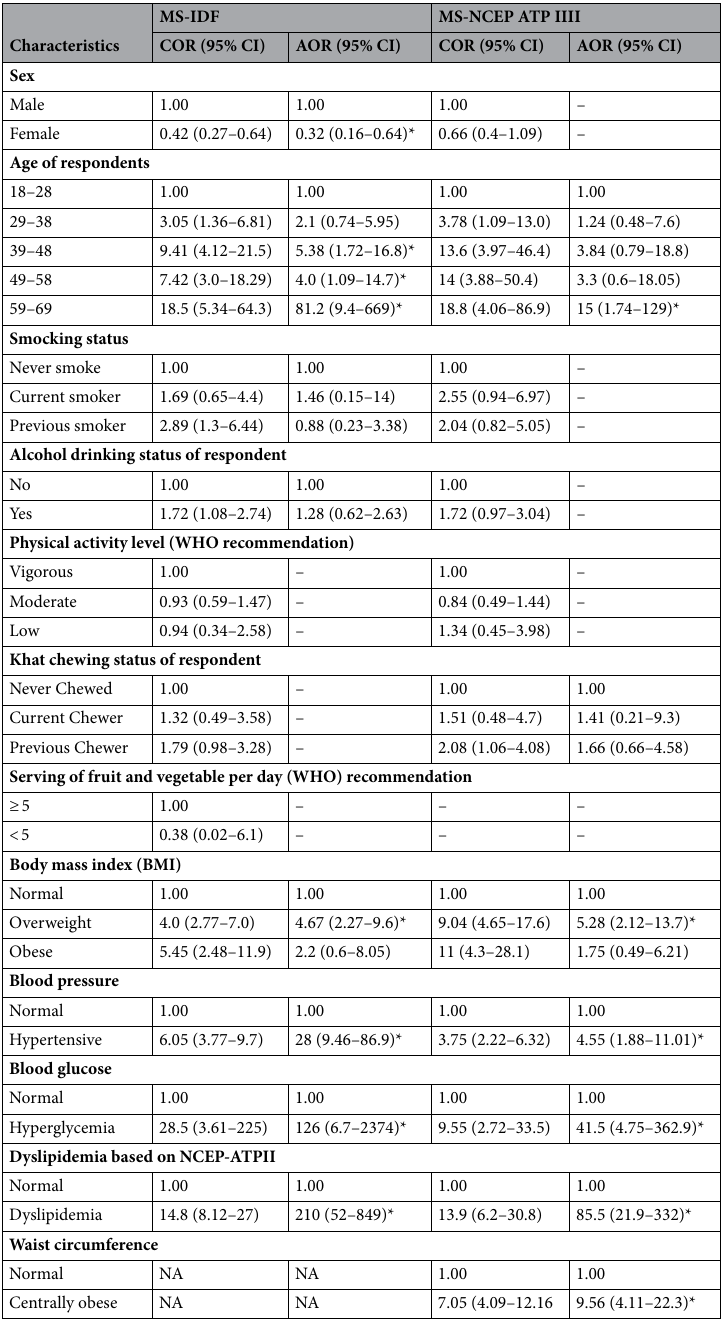
Table 6. Bivariate and multivariate analyses of risk factor components for metabolic syndrome of study subjects. EPHI, Addis Ababa, Ethiopia, 2018 (n = 450). MS-IDF metabolic syndrome based on IDF